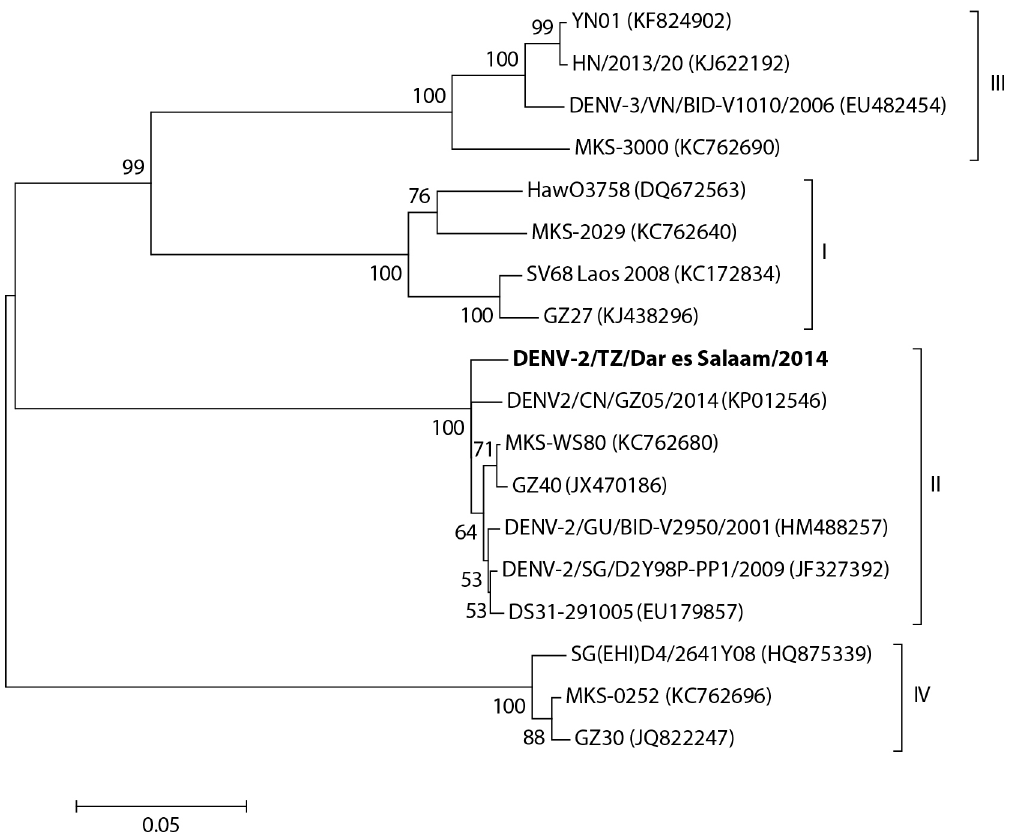
Fig 3. Neighbor-joining tree depicting the four serotypes of dengue virus. Dengue virus in mosquitoes collected in Dar es Salaam (indicated in bold) clustered into serotype 2. The percentage of replicate trees in which the associated taxa clustered together in the bootstrap test (1000 replicates) is shown adjacent to the